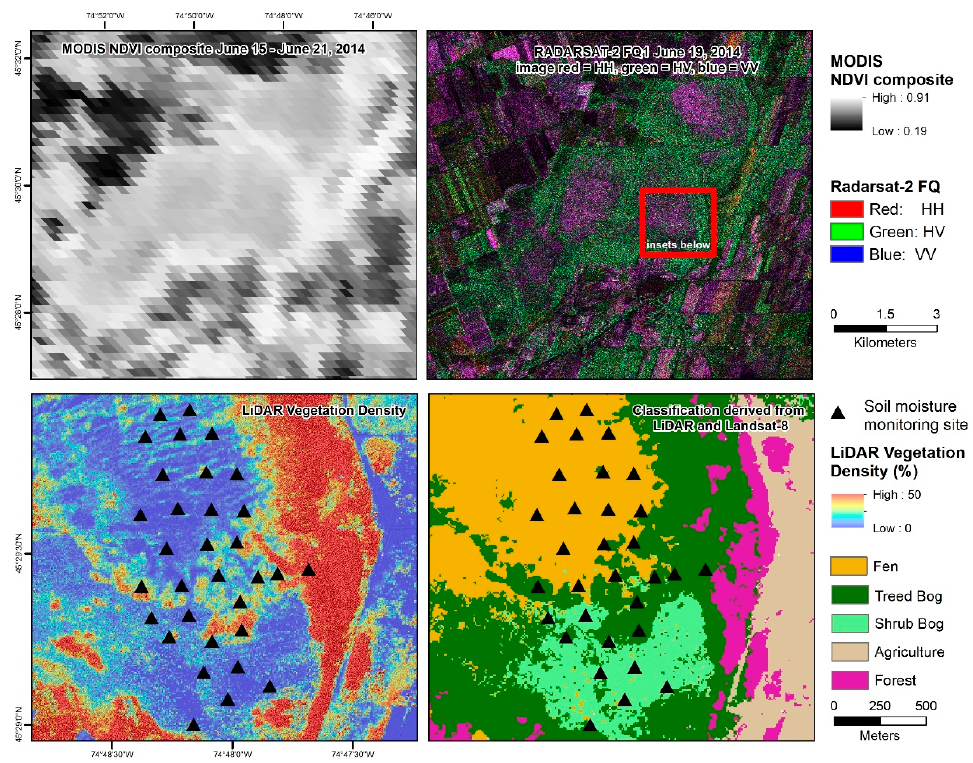
Figure 2. Locations of sampling sites within Alfred Bog.